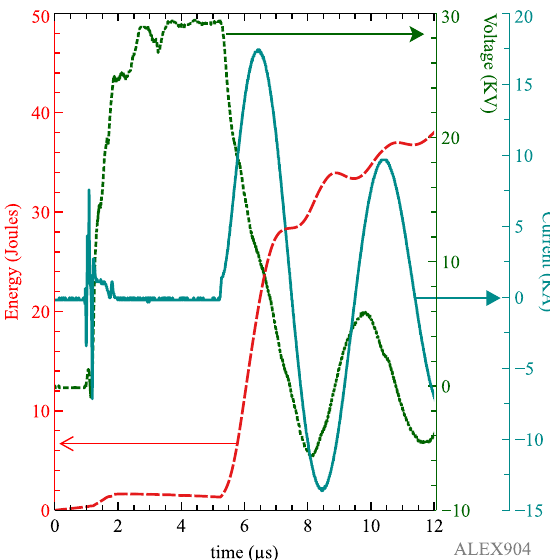
Figure 8. (Color online) energy absorbed (– –), voltage(- -), and current(—) flowing through an iron wire when charging voltage was 20